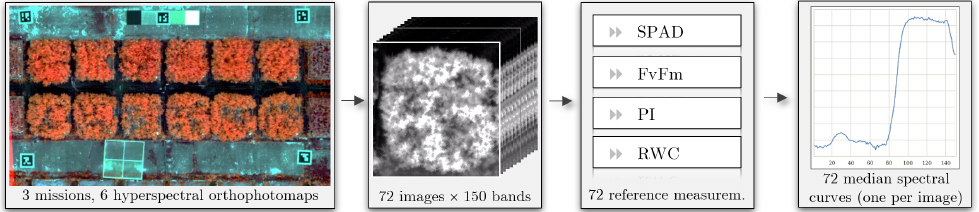
Figure 2. The dataset preparation procedure: 6 hyperspectral orthophotomaps, one for each flight for each set of 12 plots ( left ) were used to extract 72 hyperspectral 150-band images ( middle left ). The ground measurements of four parameters were performed for each plot ( middle right ). We extracted the spectral curves, individually for each pixel and aggregated across all pixels—see, e.g., the median spectral curve in the far right